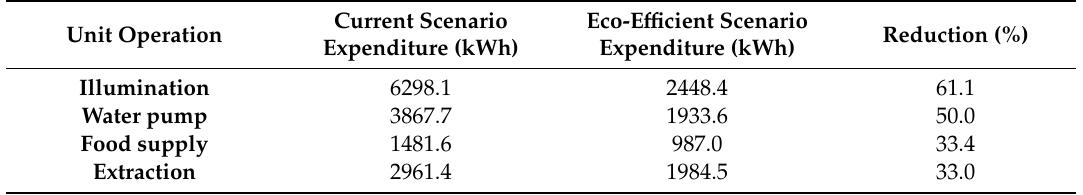
Table 7. Comparison of the energy expenditure of the current state vs. the eco-e ffi cient scenario for the egg production process at Laguna Colorada